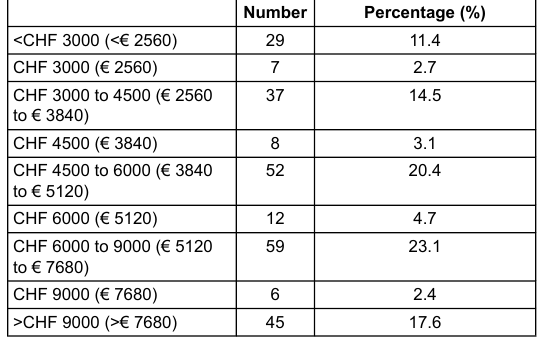
Table S1: Income categories based on the original self-reported ques- tionnaire (n = 255).